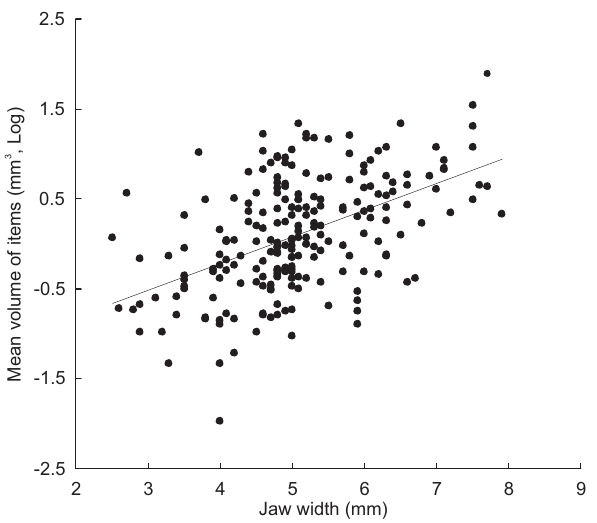
Figure 1. Relationship between jaw width (mm) and mean volume (mm 3 ) of food items (in log) ingested by I. parva in Santuário Ecoló- gico da Serra da Concórdia.